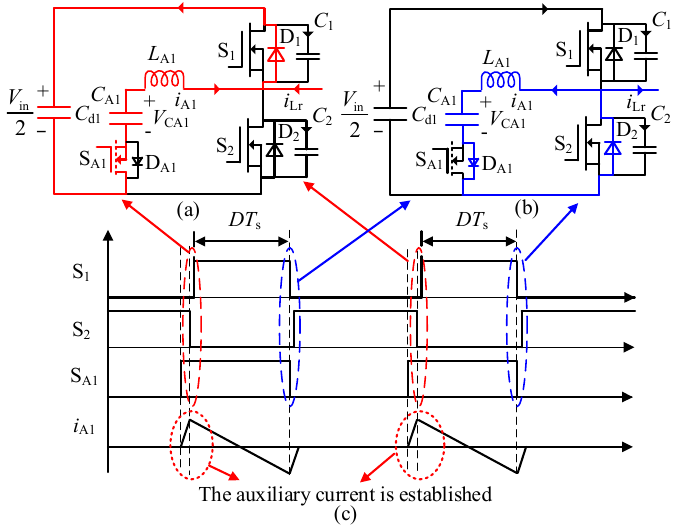
Figure 3. Working principle and the auxiliary current of the upper ACAC. ( a ) ZVS turn on condition for S 1 . ( b ) ZVS turn on condition for S 2 . ( c ) Theoretical waveforms.